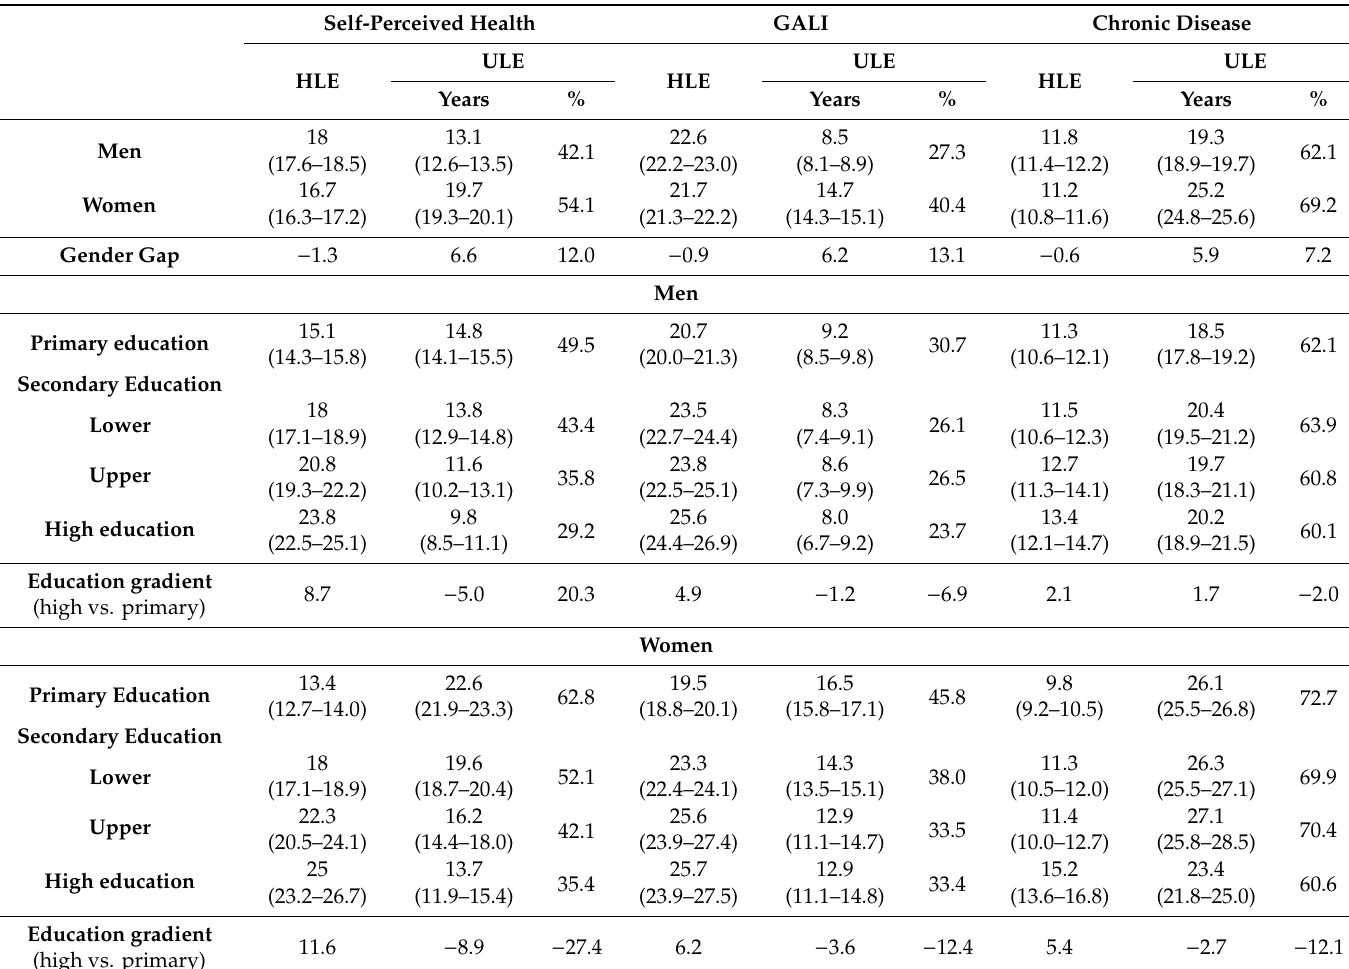
Table 3. Healthy life expectancy and unhealthy life expectancy (ULE), years, and percent in each health indicator by gender and education level for ages